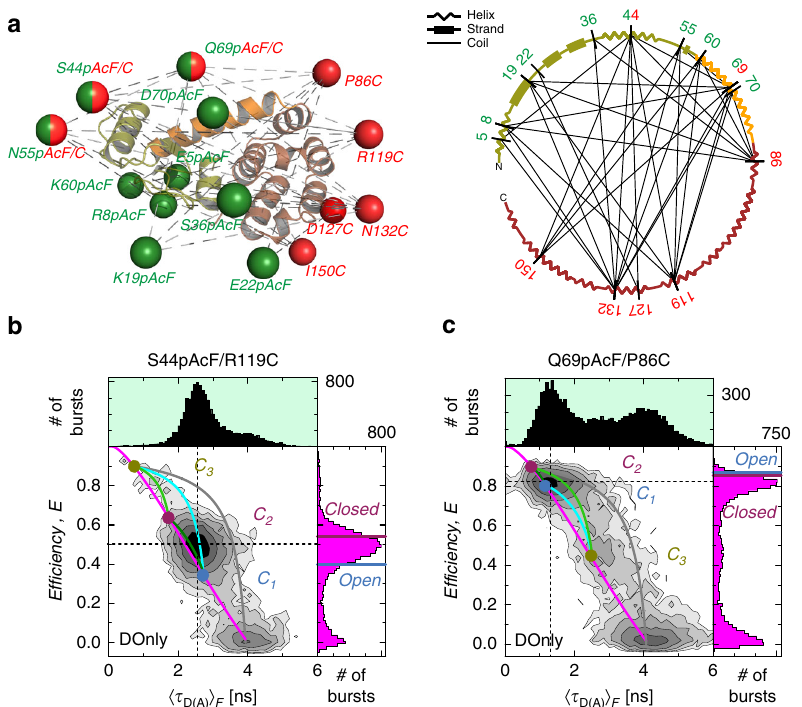
Fig. 2 FRET studies probe T4L structure and dynamics. a Network representing 33 measured distinct FRET-variants of T4L. The donor (D) Alexa488- hydroxylamine and acceptor (A) Alexa647-maleimide are coupled to para -acetylphenylalanine (pAcF) and cysteine (C), respectively. The spheres in the left panel represent the average donor (green) and acceptor (red) position for a structure of T4L (PDB ID: 172L) that is determined by the FRET Positioning System (FPS) 10 . Positions 44, 55, and 69 are used for donor and acceptor labeling. Right panel shows the secondary structure elements (helix, strand or coil) of T4L. The labeling positions are indicated and network pairs are connected. The N-terminal lobe is shown in green, the connecting helix c in orange and the C-terminal lobe in brown. b , c The FRET-ef fi ciency, E , and fl uorescence lifetime of D in the presence of A, 〈 τ D(A) 〉 F , of the DA-labeled T4L